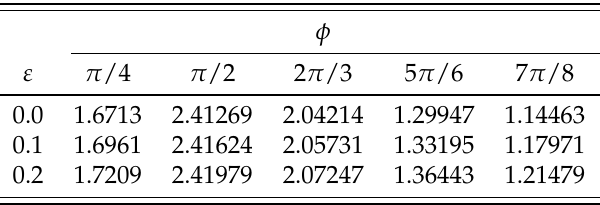
Table 1. Z (Heat transfer coefficient) as function of ϕ and ε . Here x = 0.1, Q = − 1.2, M = 4, λ 1 = 1, Br = 0.5, β 1 = 0.2, β 2 =